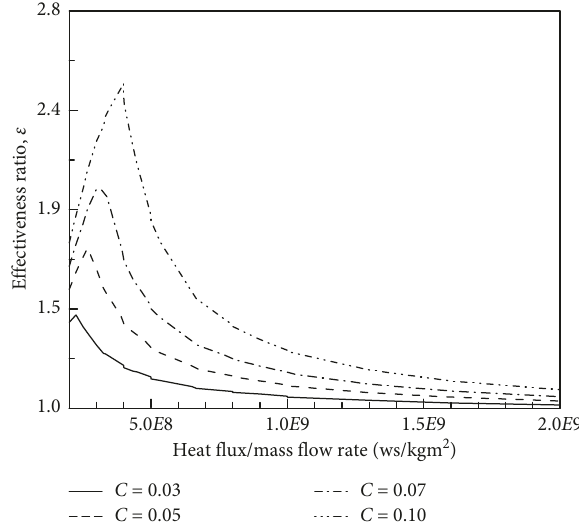
Figure 4: Effect of heat flux per unit mass flow rate on the ef- fectiveness ratio at various concentrations of S44 PCM slurry.